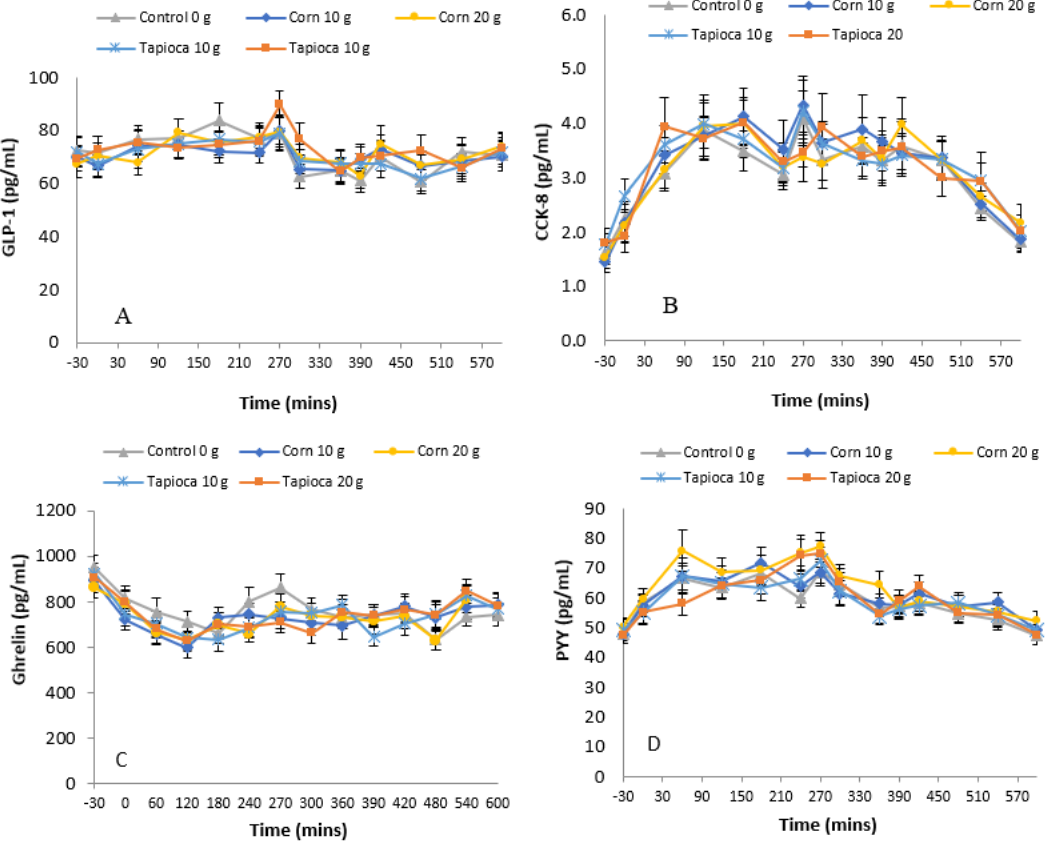
Figure 2. Plasma hormone responses for GLP-1 ( A ), cholecystokinin ( B ), ghrelin ( C ), and peptide YY ( D ) measured from baseline through 600 min. Indicates statistical significance from control ( p < 0.05). GLP-1: Glucagon-Like-Peptide-1, CCK-8: Cholecystokinin, PYY 3-36 : Petptide